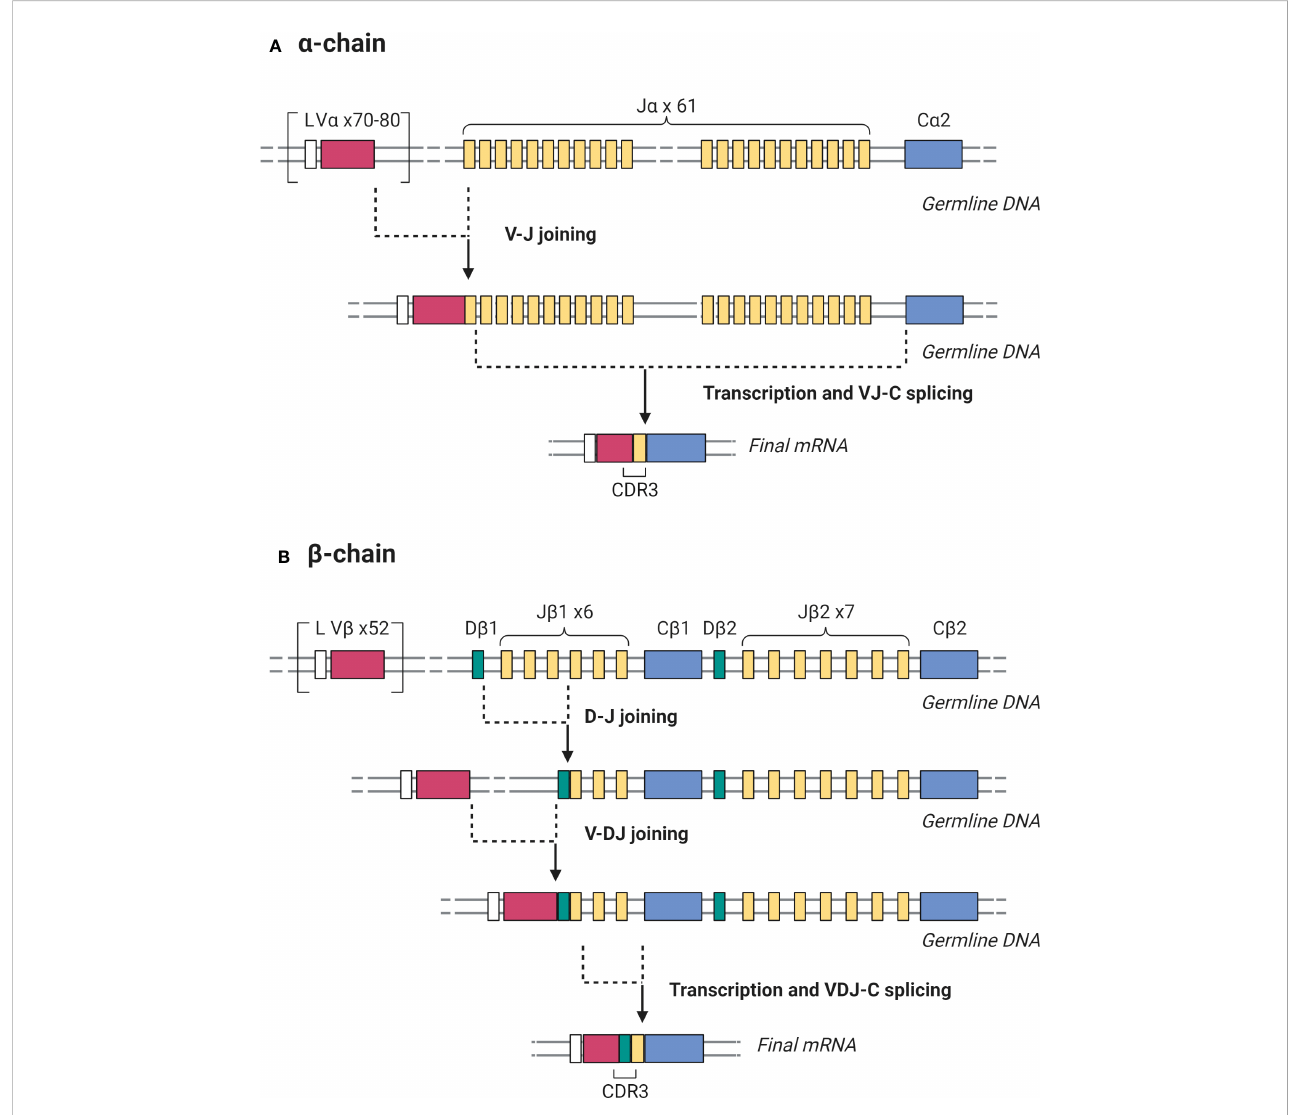
FIGURE 2 Somatic recombination of the germline DNA encoding TCR a and b chains during T cell development generates antigen-binding diversity. (A) For the TCR a chain, V-J rearrangement is followed by transcription and splicing to create a complete VJ-C mRNA. (B) For the b chain, D-J rearrangement is followed by V-DJ rearrangement, then transcription and splicing to create a complete VDJ-C mRNA. In both cases, the mRNA product is then translated to yield the protein receptor chains. The CDR3 region is the most variable portion of the TCR due to its location in the junction where V-J and V-D-J joining occurs in the a and b chains respectively. Created with BioRender.com.